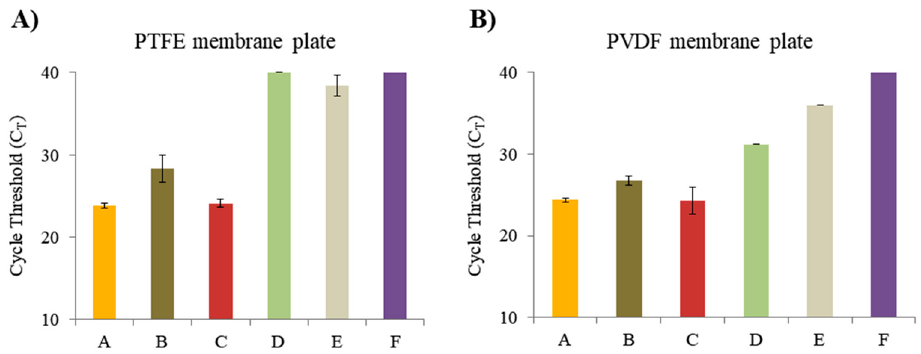
Figure 4. The 96-well filter/membrane plate evaluation of different properties. ( A ) Cycle threshold (C T ) values extracted in the 96-well filter/membrane plate (0.45 µm pore size, hydrophobic polytetrafluoroethylene (PTFE)) from each different mixture in the same manner. ( B ) The C T values extracted in the 96-well filter/membrane plate (0.45 µm pore size, hydrophilic PVDF membrane) from each different mixture in the same manner. A; QIAamp DNA Mini Kit. B; AD-DMP filter plate system without D-APDMS, DMP. C; AD-DMP filter plate system. D; Lysis buffer of AD-DMP filter plate system. E; AD-DMP filter plate system without E. coli . F; DW. It was done in the same volume using PBS. The C T values of 40 are samples that did not detect. Error bars indicate standard deviation from the mean, based on at least three independent experiments.